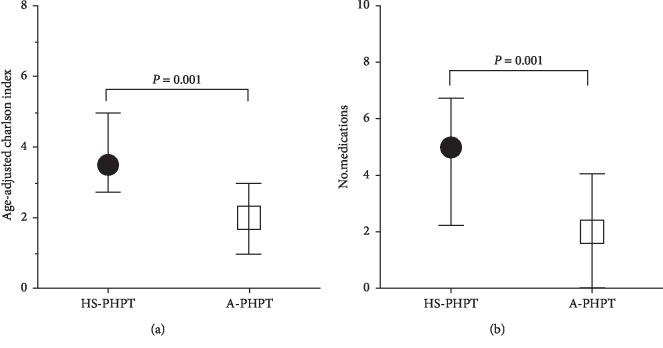
Differences in multimorbidity and polypharmacy between HS-PHPT and A-PHPT. Median values of age-adjusted Charlson index (a) and of the number of medications (b) differed between HS-PHPT and A-PHPT patients. Data are presented as median and range interquartile by box, and wisker plots represent minimum and maximum values. Statistical significance was determined by the Mann–Whitney test. HS-PHPT, hypercalcemic-related symptomatic PHPT (black circles); A-PHPT, asymptomatic PHPT (grey squares).